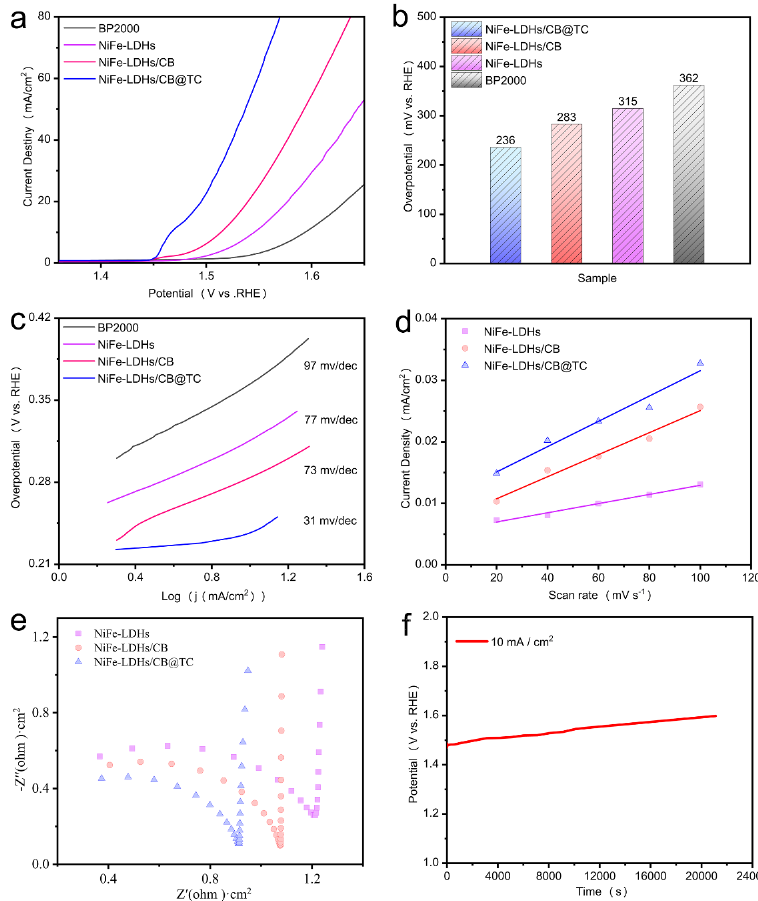
Figure 6. ( a ) Polarization curves of various samples and corresponding ( b ) comparison of overpotential at 10 mA/cm 2 , ( c ) Tafel slopes; ( d ) Linear plots of cathodic charging currents versus the scan rate and ( e ) electrochemical impedance spectra of NiFe LDHs, NiFe LDHs/CB, NiFe LDHs/CB-TC; ( f ) Chronopotentiometry test of NiFe LDHs/CB-TC at 10 mA/cm 2 in 1M KOH.